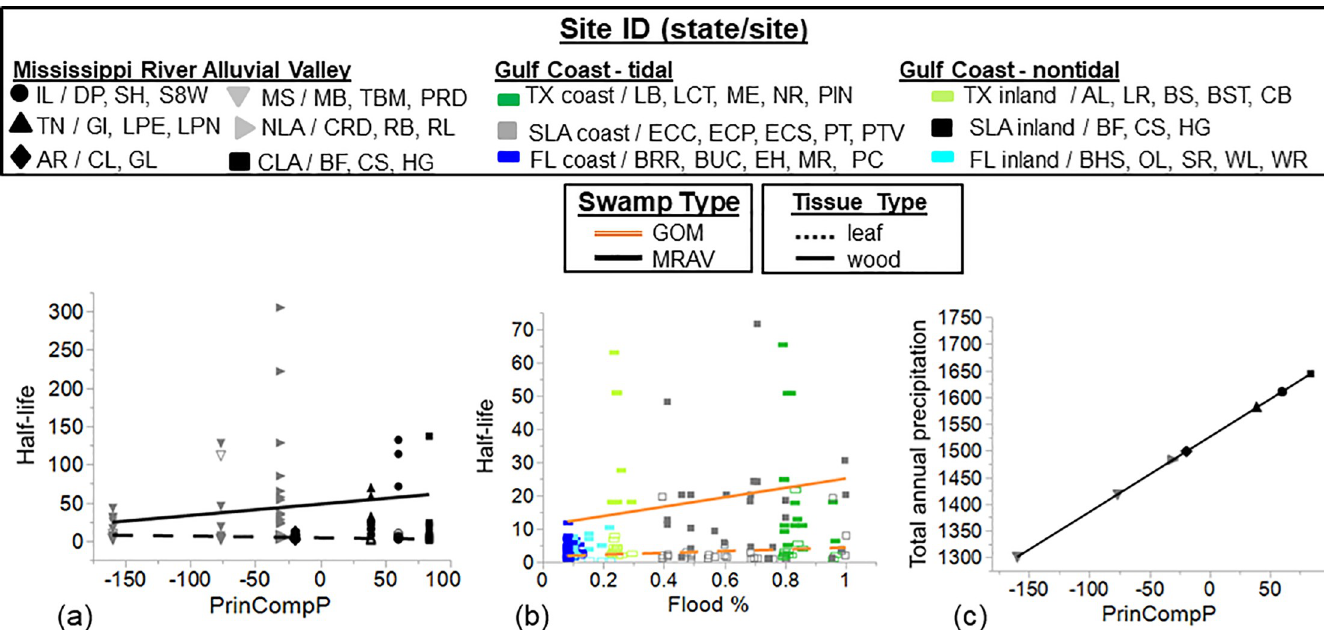
Fig 3. Relationship of T . distichum leaf and wood (a-f; dashed vs. solid line, and outlined vs. solid rectangle, respectively) half-life (50% turnover time) with best fit regressions of selected significant covariables fitting linear, log and polynomial fits of regressions for responses in the MRAV for (a) principal component of precipitation (PrinCompP; no interaction; S4 Table), and in GOM for (b) flood % (1—drawdown %; no interaction; S4 Table. Also shown is a (c) linear regression of PrinCompP with total annual precipitation. The equation for the principle component of precipitation in 2007 is PrinCompP = Total annual precipitation � 0.707107 + Mean annual precipitation � 0.707107. Regression models were prepared only for selected climatic and environmental variables identified as significant by PROC GLMSELECT (VIF < 10; S4 Table).